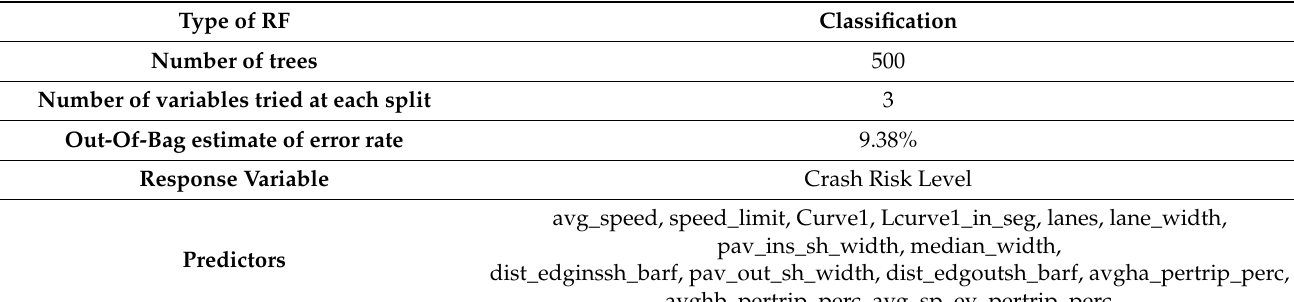
Table 4. Key elements of the crash risk level classification model’s